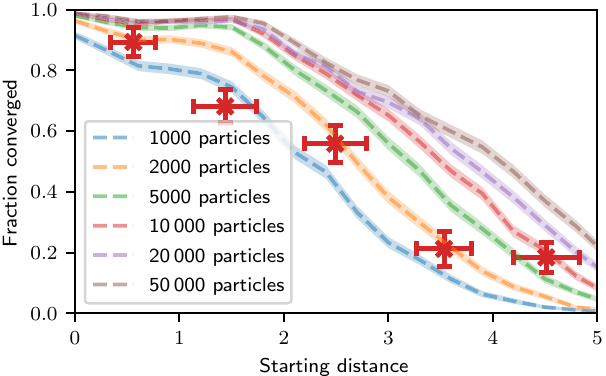
FIG. 9. Capture range of the algorithm. The width of the ini- tial Gaussian prior has been held constant at σ (cid:8) = 0.2 (cid:8) opt Rabi frequency uncertainty, σ δ = 1 × 2 π kHz sideband uncer- = 1 × 2 π kHz center line uncertainty, and σ tainty, σ ω cl 0.33 π phase uncertainty. The starting distance has been calcu- lated using Eq. (32). The fraction captured represents the number of runs that terminate within 2 times the target thresholds of the optimal parameter values. For each distance, 2000 tuneups are run. The shaded area corresponds to one standard devia- tion. For 10 000 particles, we additionally measure the capture range experimentally, where the results are represented with red squares. The error bars correspond to the statistical deviation of the data